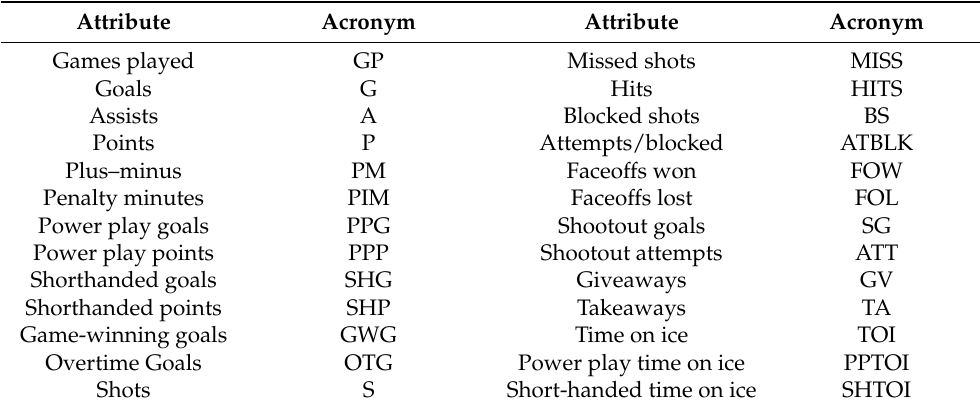
Table 1. Structure of potential